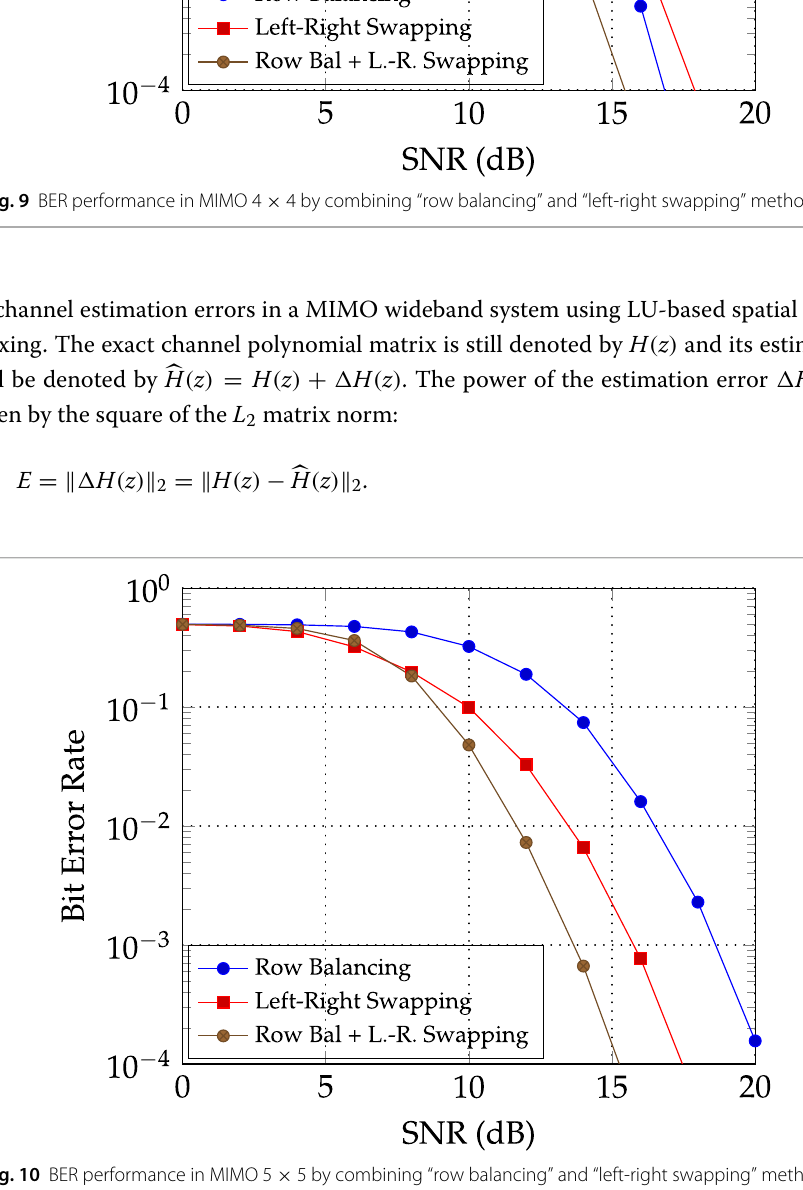
Fig. 10 BER performance in MIMO 5 × 5 by combining “row balancing” and “left-right swapping”